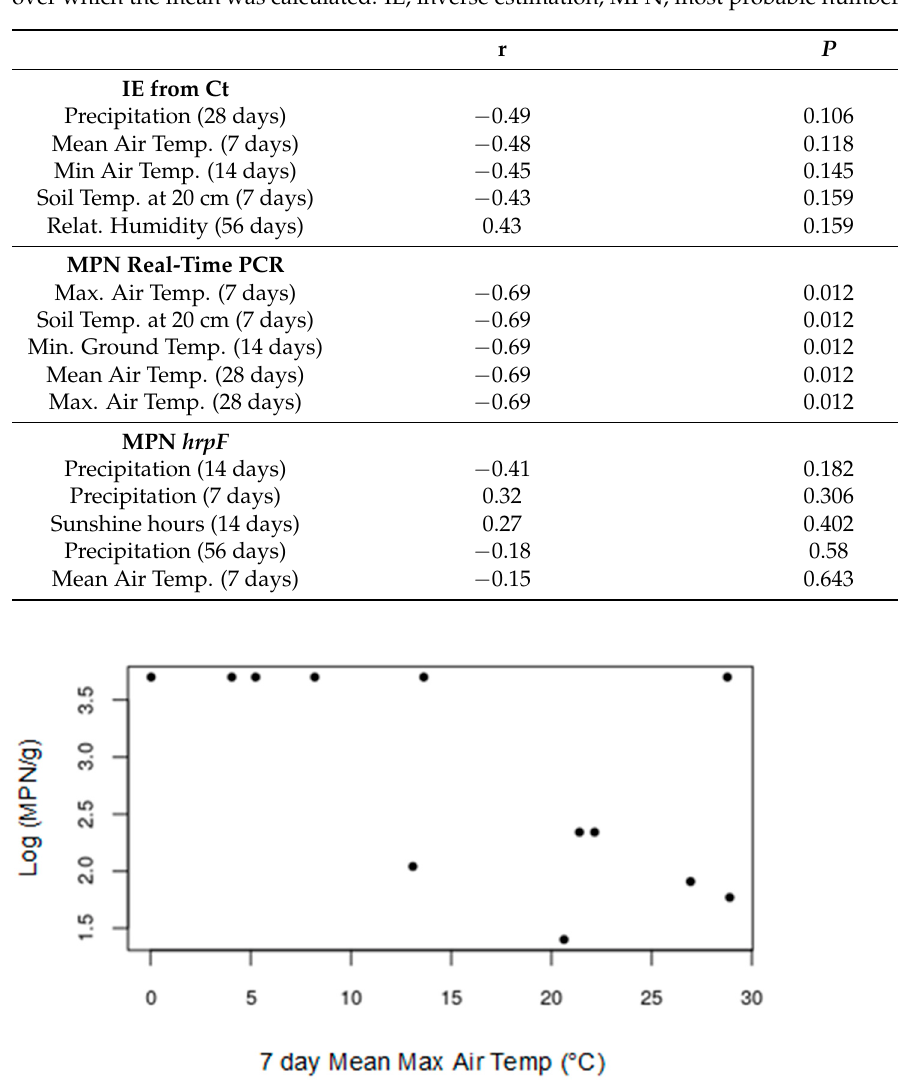
Table 2. The top five most significant correlations ( r ) between each of the Xcc estimates and means of weather variables, and their significance ( P ). The values in parentheses represents the time period over which the mean was calculated. IE, inverse estimation; MPN, most probable number.